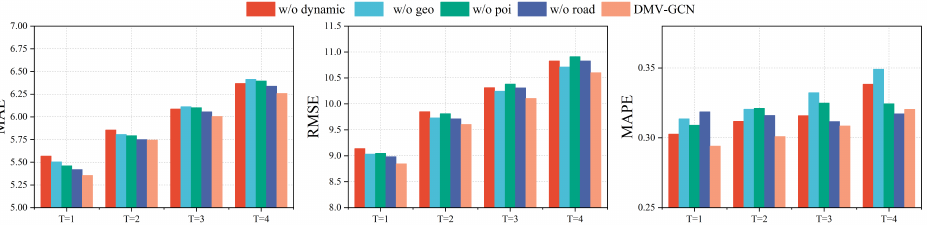
Figure 10. Performance comparison between DMV-GCN and its variant models on NYC-taxi-2019.